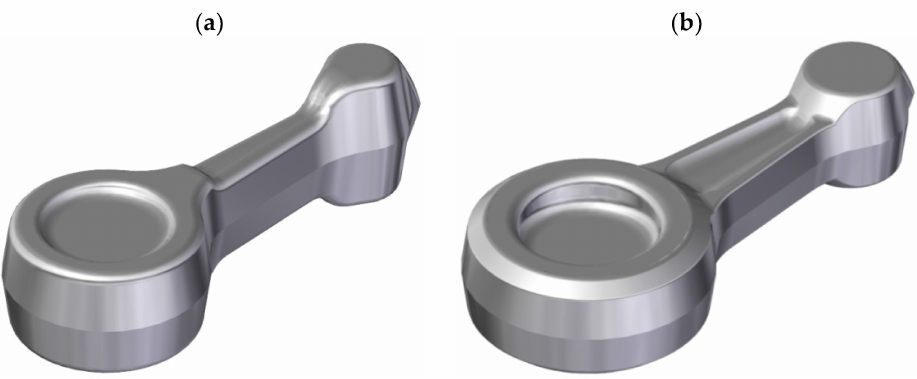
Figure 6. Three-dimensional model of the connecting rod preform: ( a ) variant 1; ( b ) variant